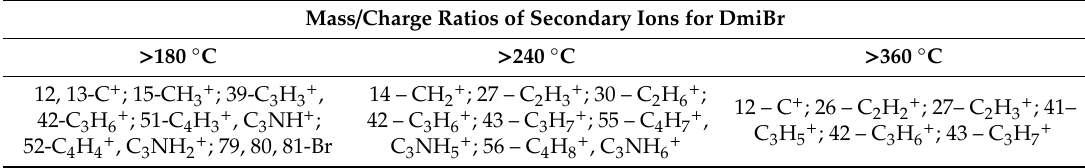
Table 2. Mass Spectrometry (MS) analysis of DmiBr.